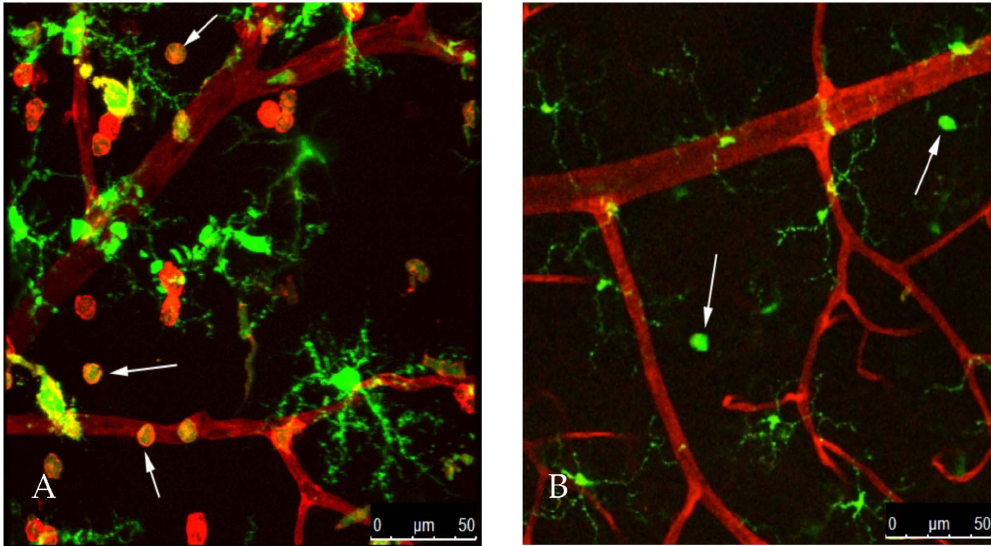
Figure. 8. Diabetic retinas of Cx3cr1-GFP/Ccl2 2 / 2 mice show significant reduction of activation of microglia and monocyte/ macrophage infiltration. Representative confocal images of retinal whole mounts from Cx3cr1-GFP ( A ) and Cx3cr1-GFP/Ccl2 2 / 2 mice with 6 weeks of diabetes ( B ) counterstained with TRITC-labeled GS IB4 isolectin for vessel and activated macrophage identification (red). ( A ) Retinas of diabetic Cx3cr1-GFP mice show activated microglia with ameboid morphology (typical of an activated state) and numerous GFP + /isolectin + round monocytes/macrophages (arrows). ( B ) Diabetic Cx3cr1-GFP/Ccl2 2 / 2 mice show a significant reduction in monocyte/macrophage infiltration. Very few monocytes/macrophages are seen in these retinas (arrows) as opposed to numerous quantities typically seen in diabetic animals (Cx3cr1-GFP). Retinas show GFP + microglia uniformly distributed with ramified processes, similar to inactivated cells.